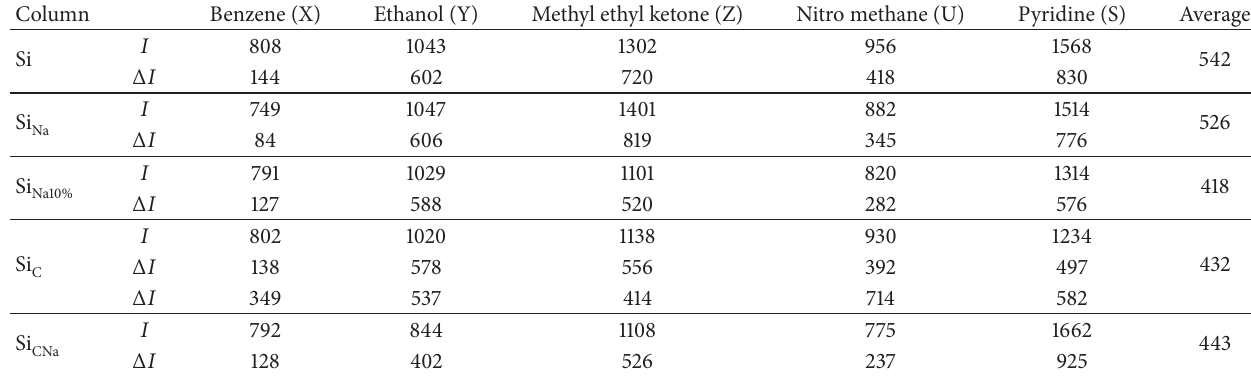
Table 2: Rohrschneider index of parent and alkali metal modified silica stationary phases.